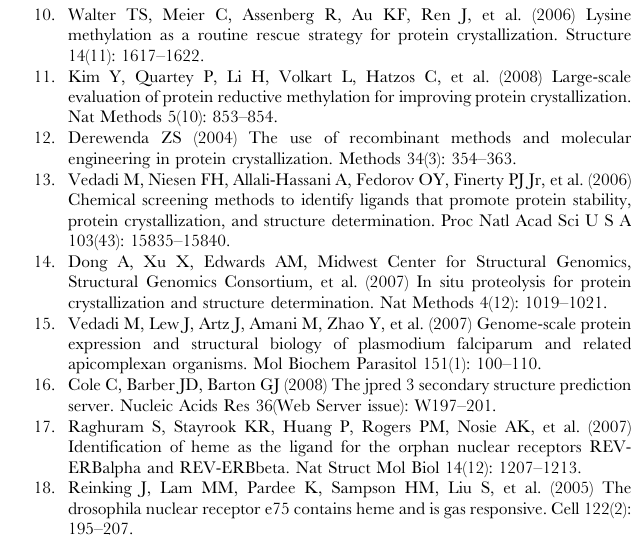
Figure S1 Crystal structure figure of a possible non-physiolog- ical dimer. Possible non-physiological dimer obtained from a 3.5 A˚ dataset collected on a crystal of rev-erb b